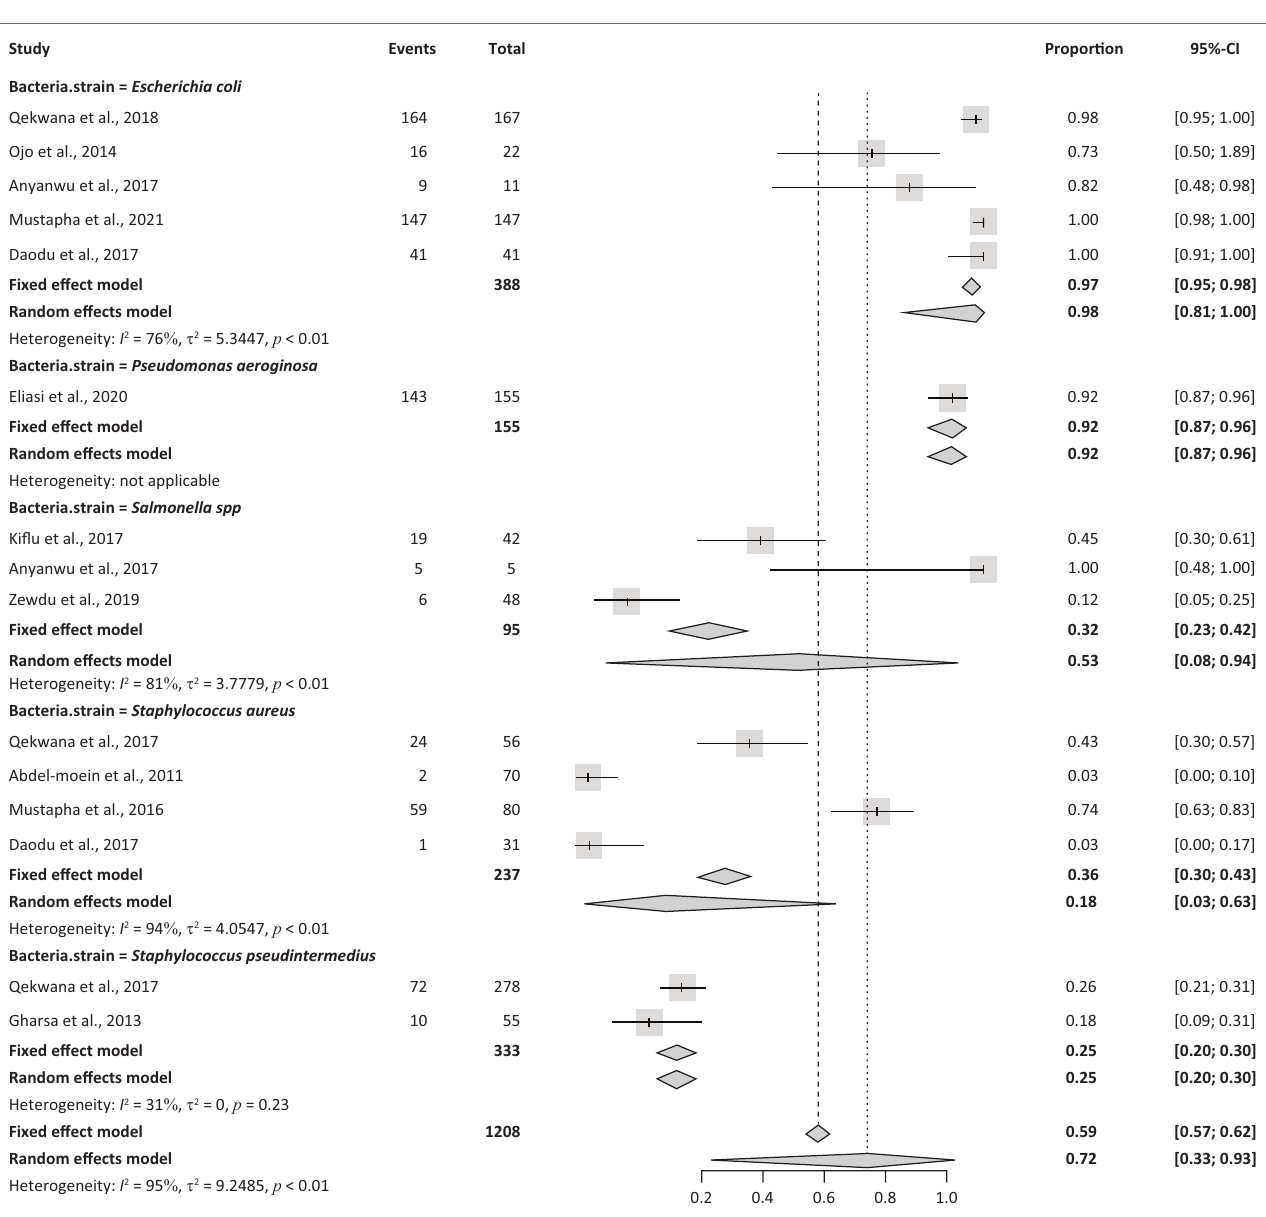
FIGURE 1-A1: Graph illustrating the multidrug resistance of bacterial strains isolated from dogs in